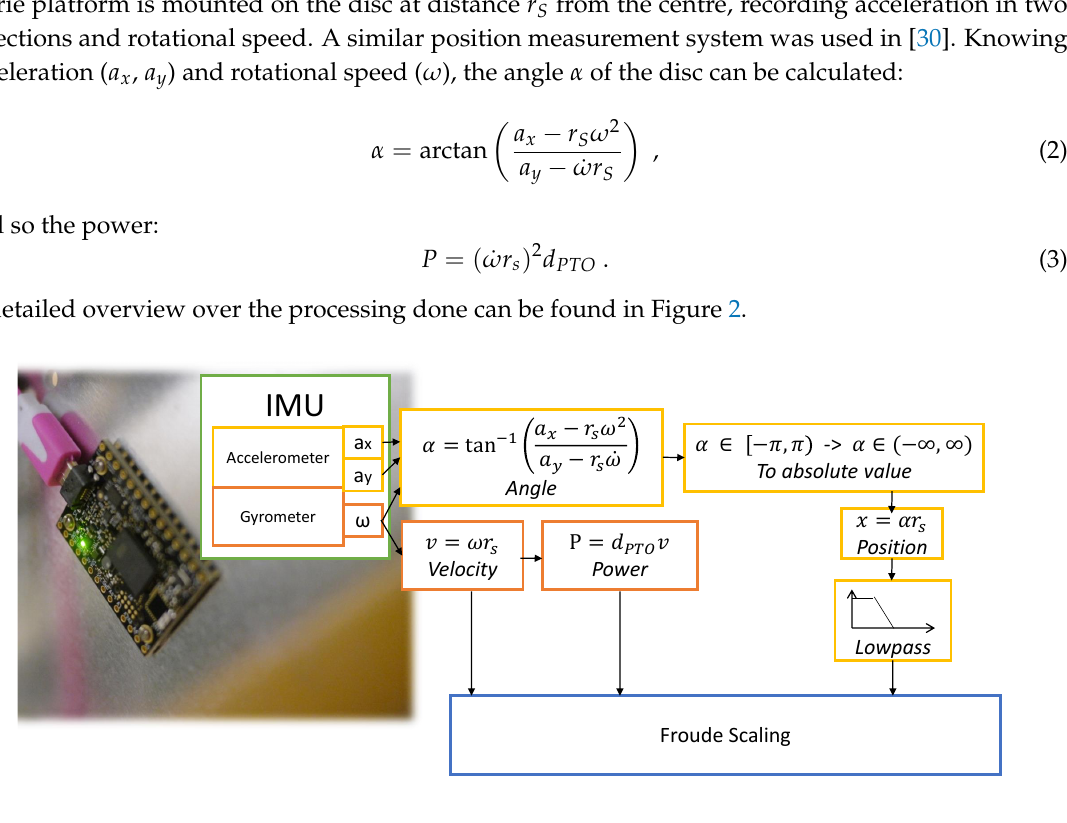
Figure 2. Processing of the measured data. Here v is the linearised velocity and x the linearised